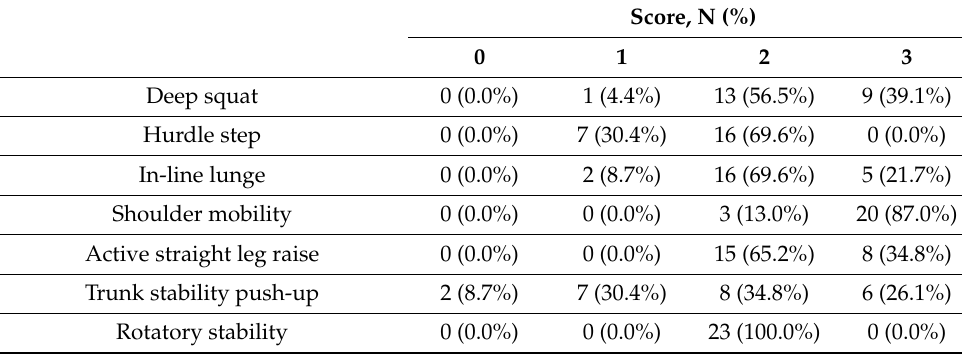
Table 3. Score distributions for FMS component tests.